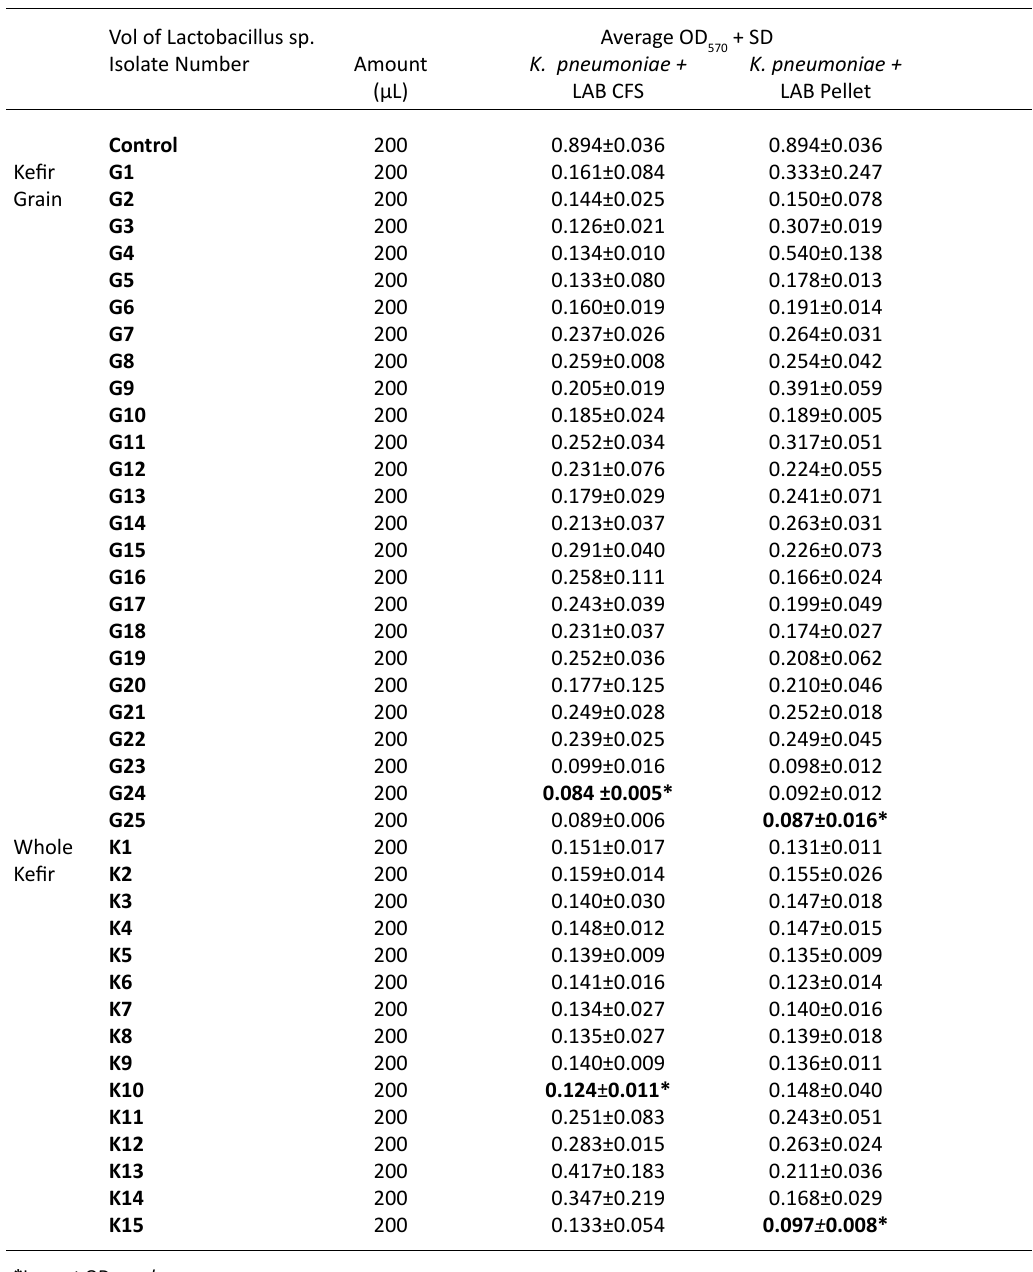
Table 2. Measurement of OD of K. pneumonia biofilm after incubation with Lactic Acid Bacteria ( p <0.001). Vol of Lactobacillus